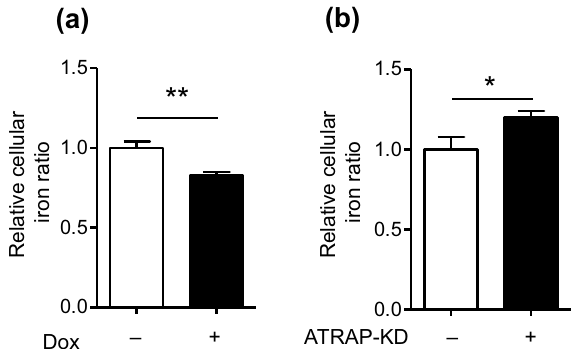
Figure 4. Effects of ATRAP expression on cellular iron levels. Cellular iron levels were assessed by detecting red fluorescence generated using the FerroOrange assay. ( a ) in Dox-inducible HEK293_F-mATRAP cells, with or without Dox treatment (Dox + /-). Unpaired t -test: ** p < 0.01 vs. Dox+ cells (n = 6). ( b ) in HEK293 cells treated with siRNA targeted ATRAP (ATRAP-KD) or control siRNA (control). Unpaired t -test: * p < 0.05 vs. ATRAP-KD cells (n = 6). The data shown are presented as the mean ±